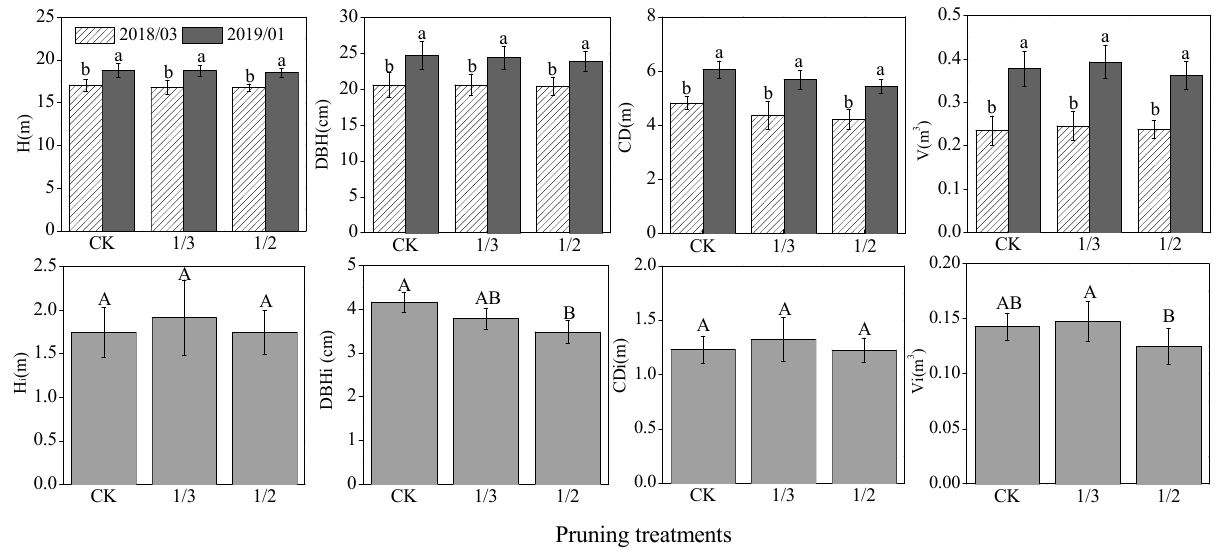
Figure 1. Growth characteristics of poplar after pruning treatments. Note: H represents tree height, Hi represents the tree height increment; DBH represents diameter at breast height, DBHi represents the increment of diameter at breast height; CD represents crown diameter, CDi represents the increment of crown diameter; V represents stem volume, Vi represents the stem volume increment. Different lowercase letters indicate significant differences between different sampling times in the same treatment ( p < 0.05); different capital letters indicate significant differences between different pruning treatments during the same period ( p < 0.05). The error bars are the standard errors.